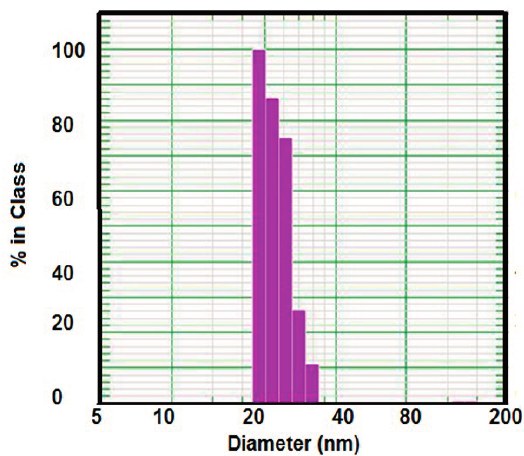
Figure 3. DLS of AA-Na/magnetite composite